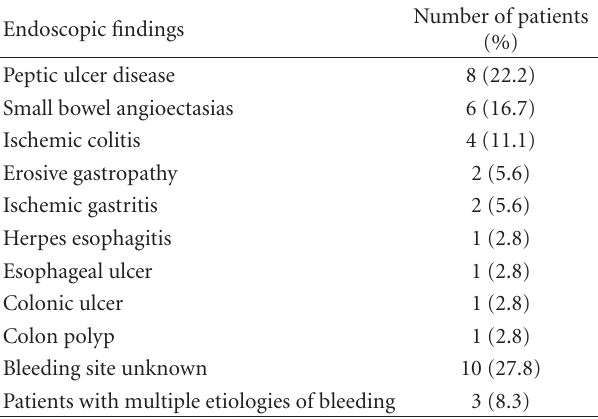
Table 2: Endoscopic findings in 20 VAD patients admitted for 36 overt GI bleeding episodes.